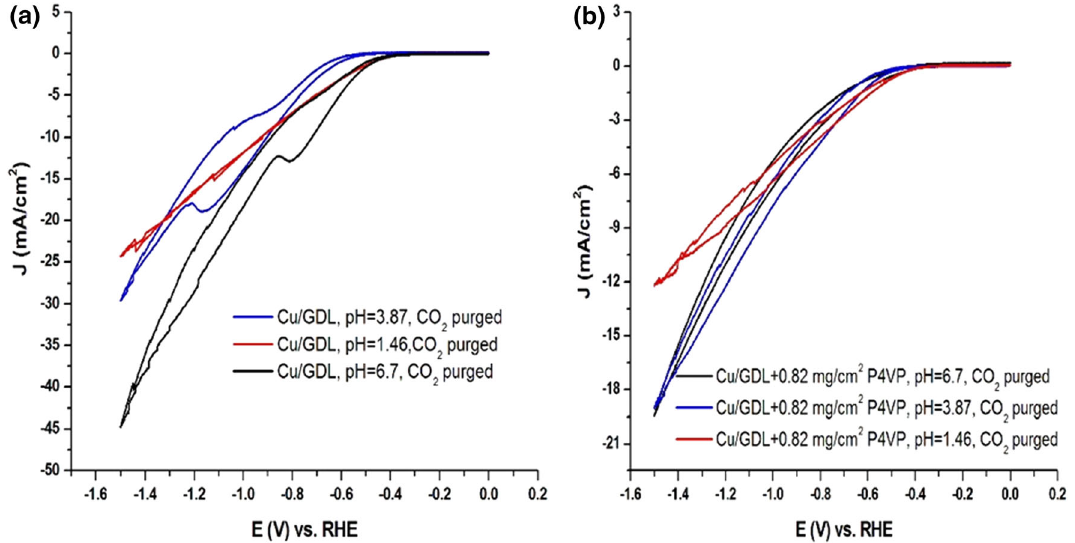
Fig. 2 CV curve of Cu/GDL with different P4VP loadings in phosphate buffer electrolyte at pH 1.46, 3.87 and 6.7. a Cu/GDL, CO 2 -purged electrolyte, b Cu/GDL ? 0.82 mg/cm 2 P4VP, CO 2 -purged electrolyte. Scan rate: 50